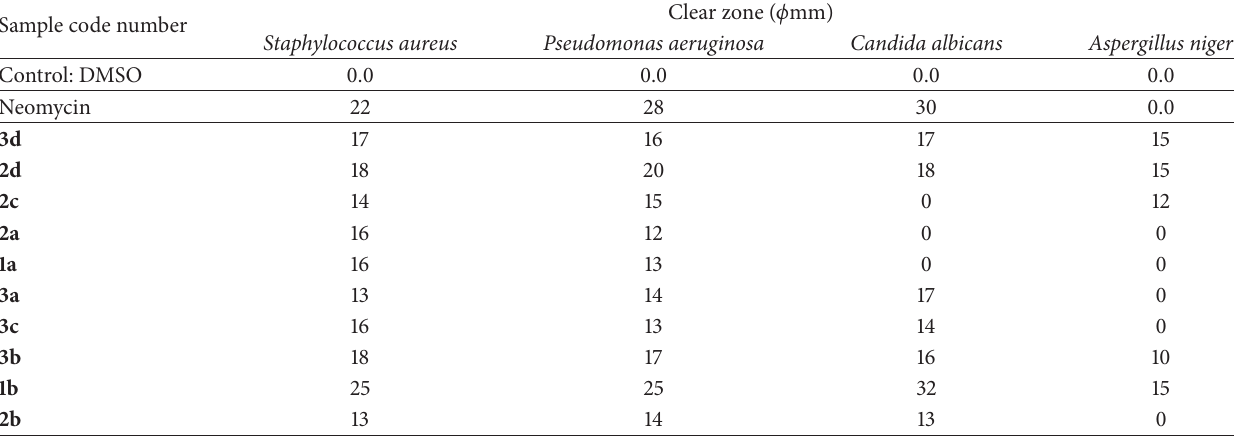
Table 1: The antimicrobial activities of the synthesized compounds as inhibition zone in mm diameter per mg